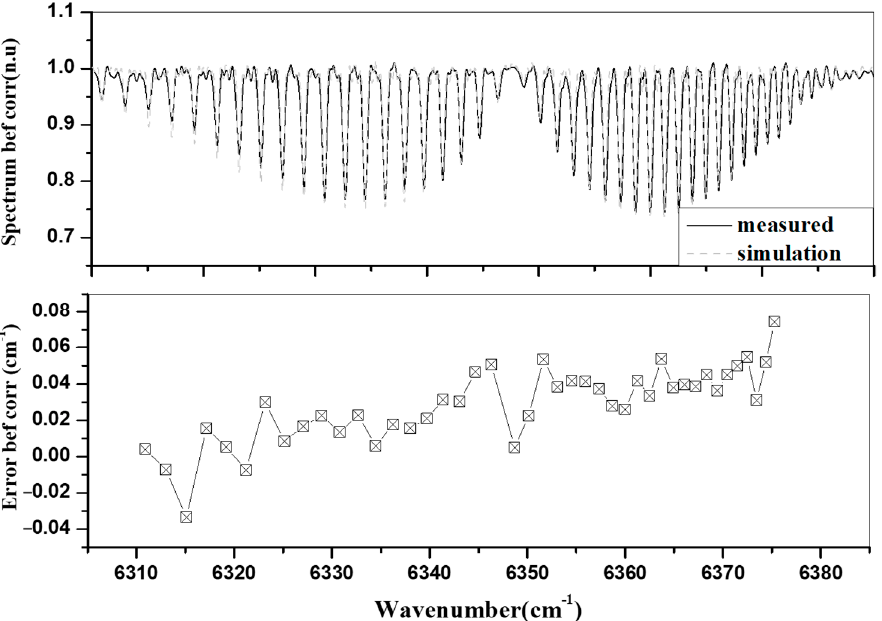
Figure 21. Position deviation of absorption peak between theoretical spectrum and measured spectrum.